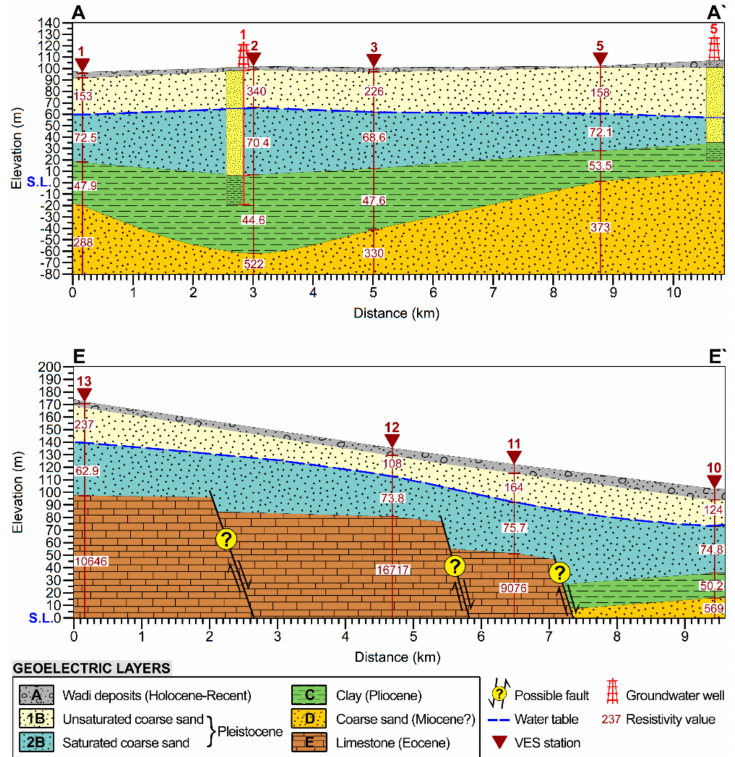
Figure 17. Selective cross-sections show the lateral distribution of the di ff erent geoelectric